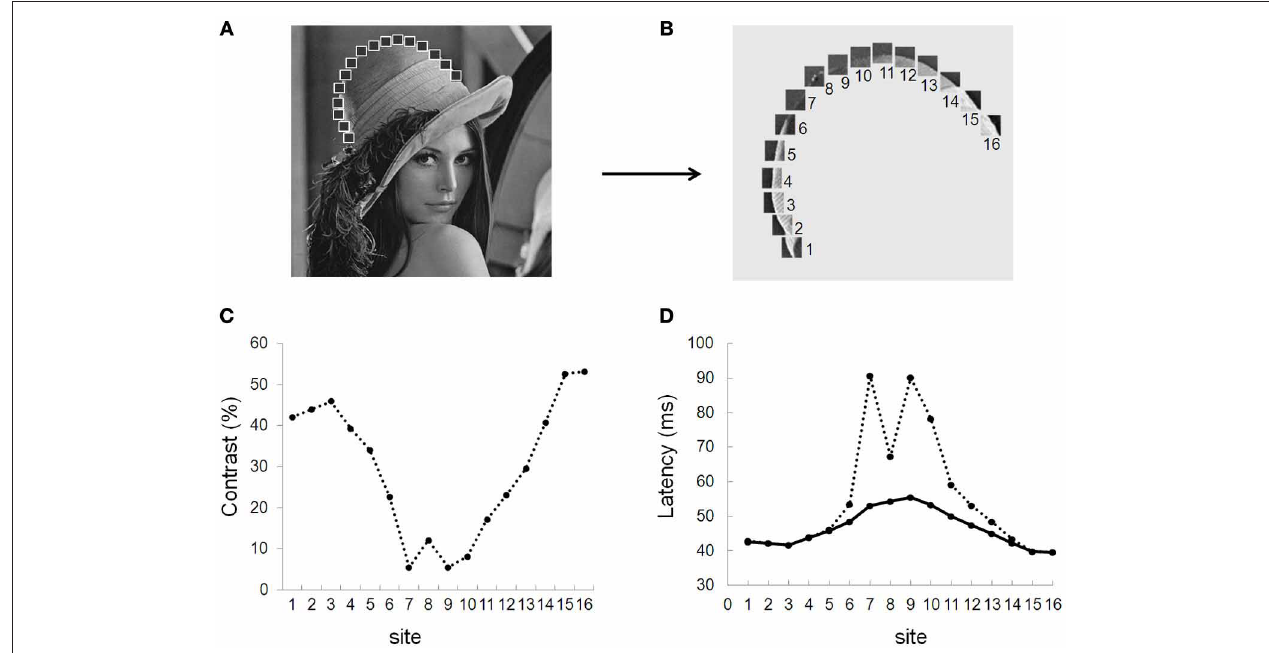
FIGURE 7 | Spike time alignment model (STAM). Simulated distribution of response latencies of the STAM model for a series of patches at different contrasts drawn from the picture of Lena (A,B) . (C) Distribution of contrast along Lena’s hat border for all sites (1–16). (D) Response latencies from the modeled neurons with (solid line) and without (dotted line) long-range connections. In this